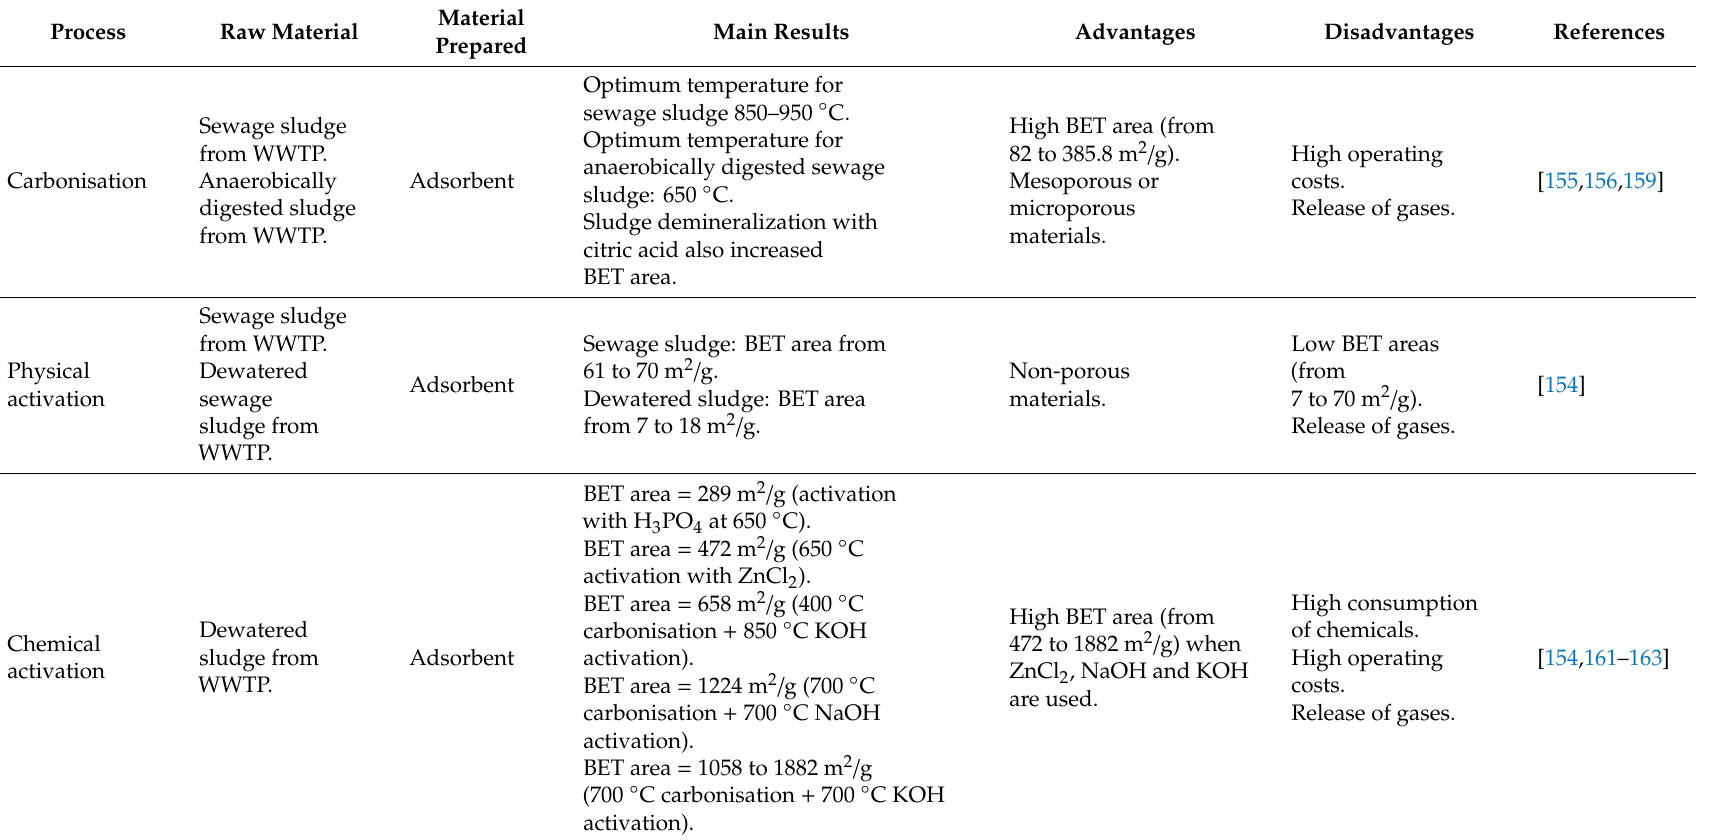
Table 8. Process employed for adsorbent preparation from sewage